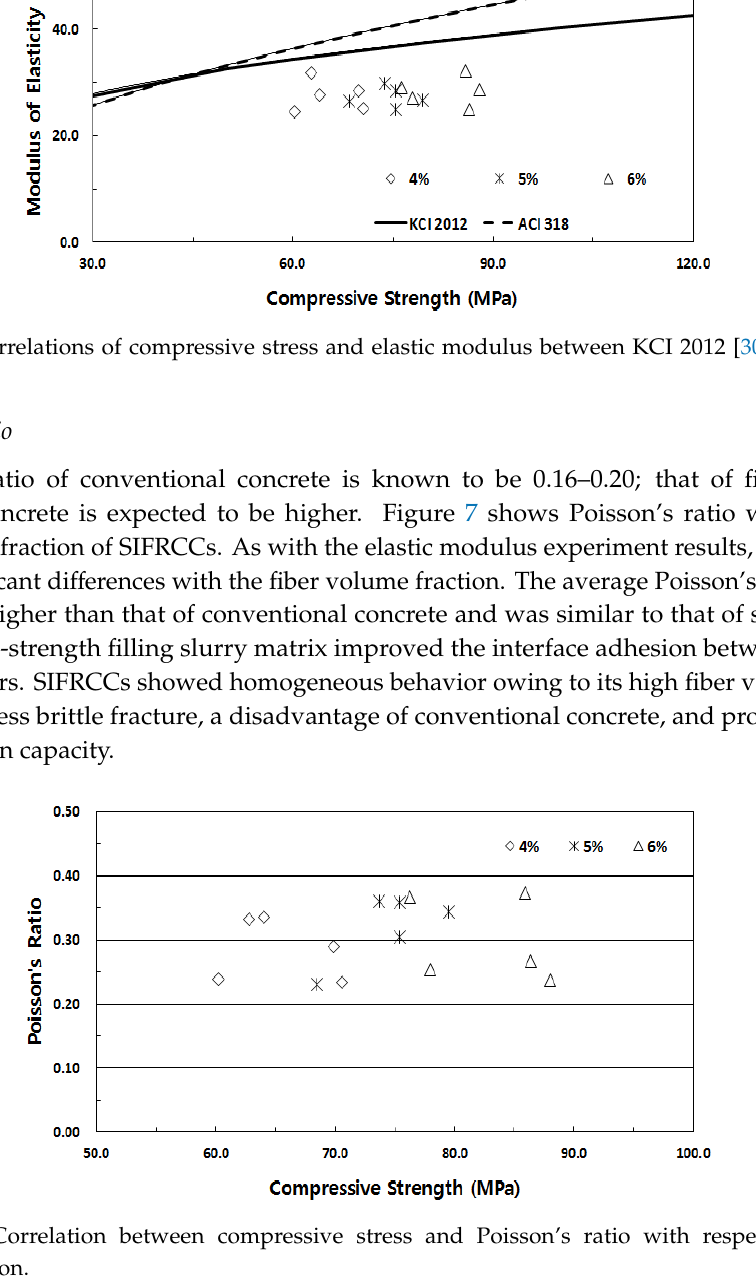
Figure 7. Correlation between compressive stress and Poisson’s ratio with respect to fiber volume fraction.